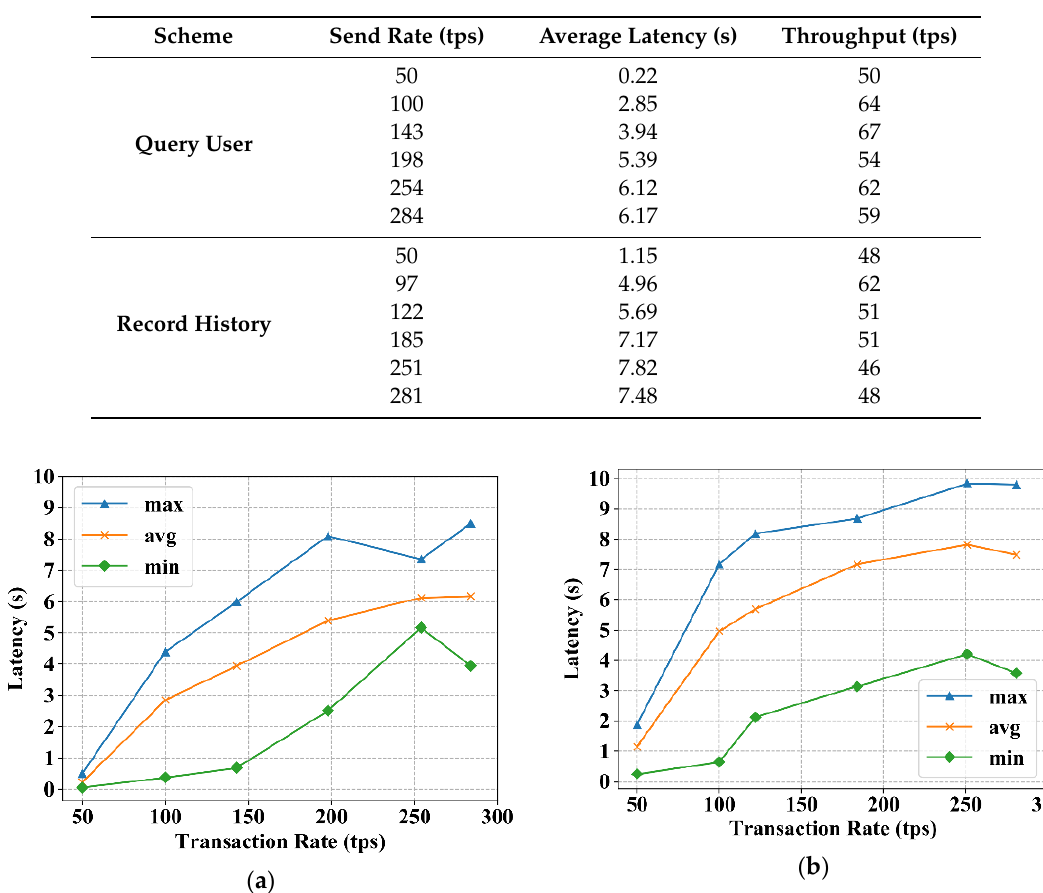
Table 4. The chaincode results of our blockchain prototype.